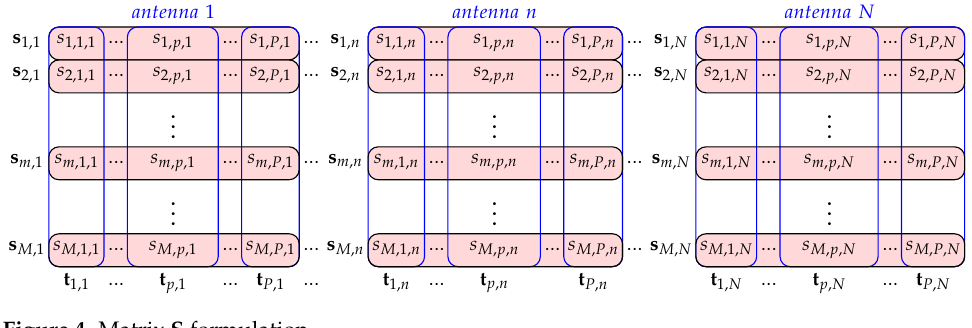
Figure 4. Matrix S